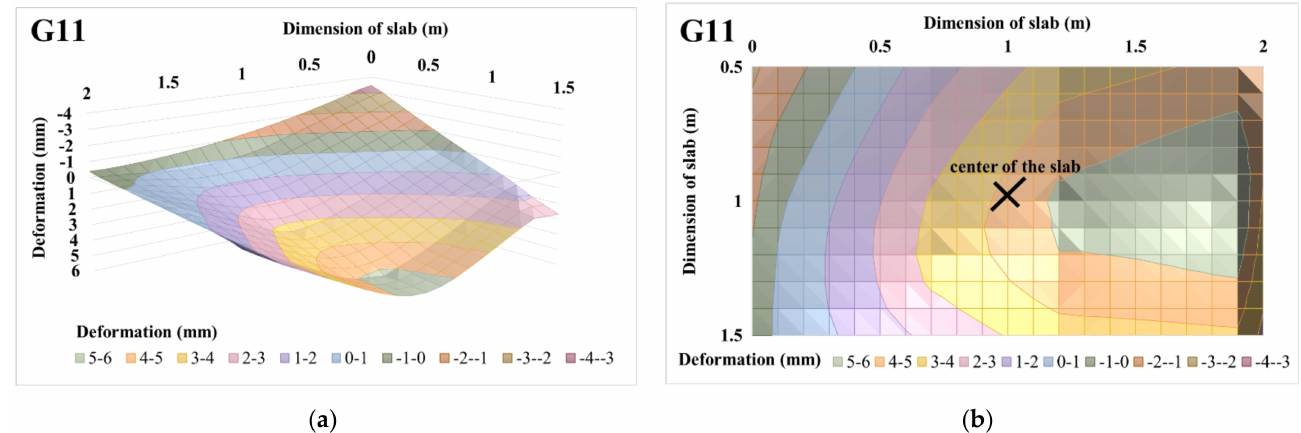
Figure 20. Eccentrically loaded slab G11 with 225 kN load: ( a ) 3D deformation surface of the slab; ( b ) projection of 3D deformation surface of the slab.